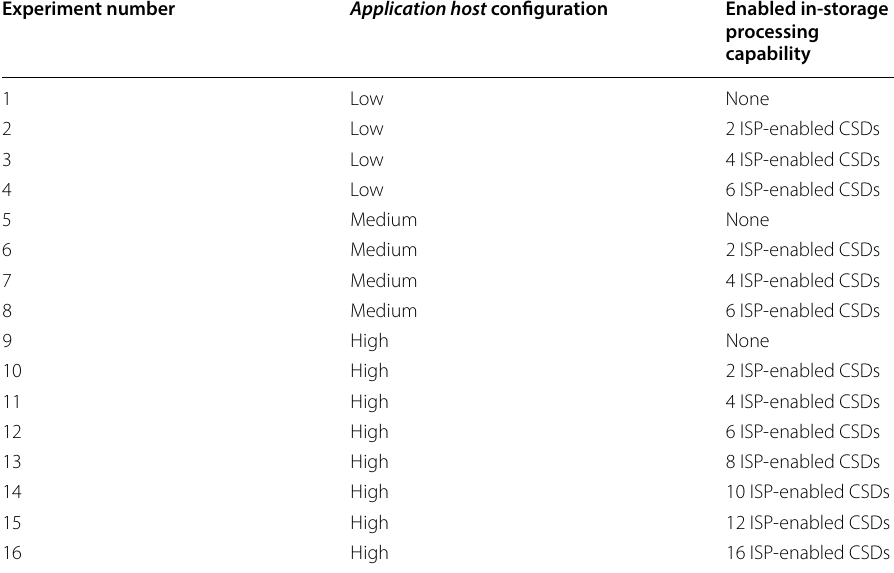
Table 3 Different configurations for running Hadoop MapReduce benchmarks Experiment